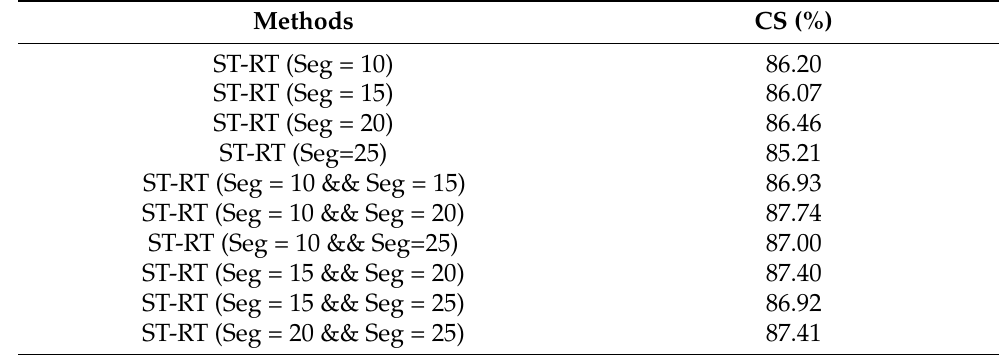
Table 6. Accuracy comparison of the ST-RT models with different sampling strategies and their combination. “X && Y” means the fusion of the model with X sampling strategy and the model with Y sampling